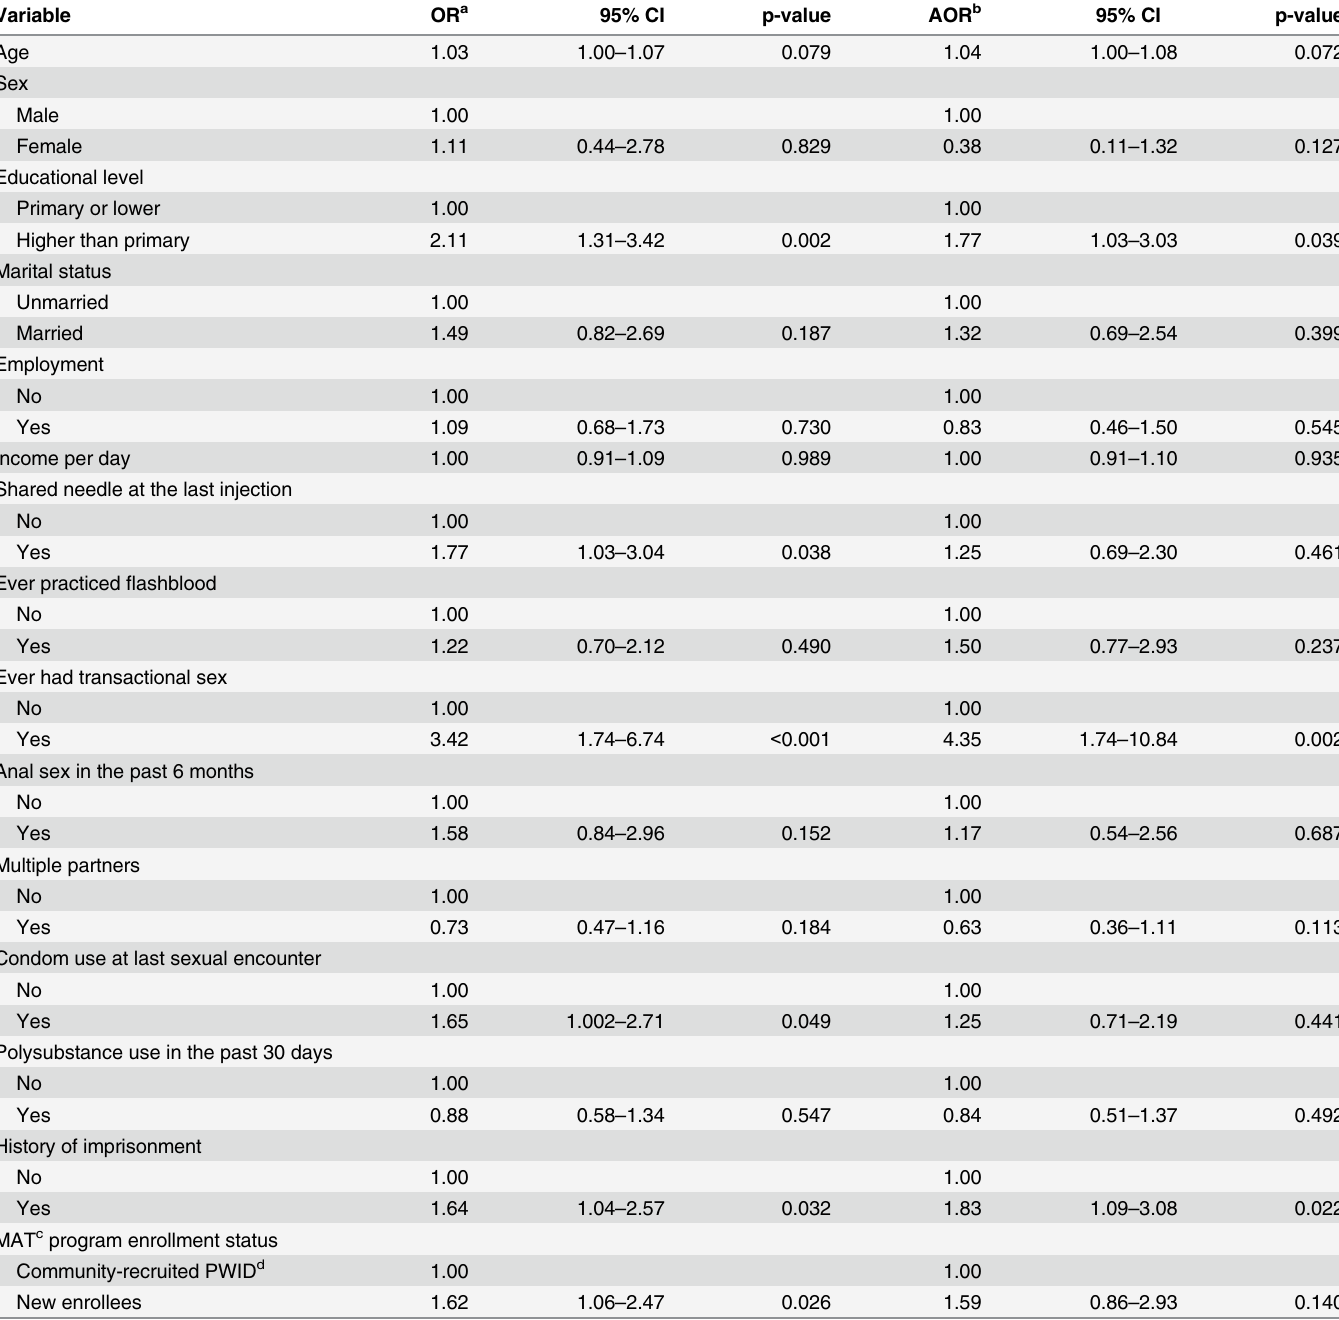
Table 6. Factors associated with ever being screened for tuberculosis among